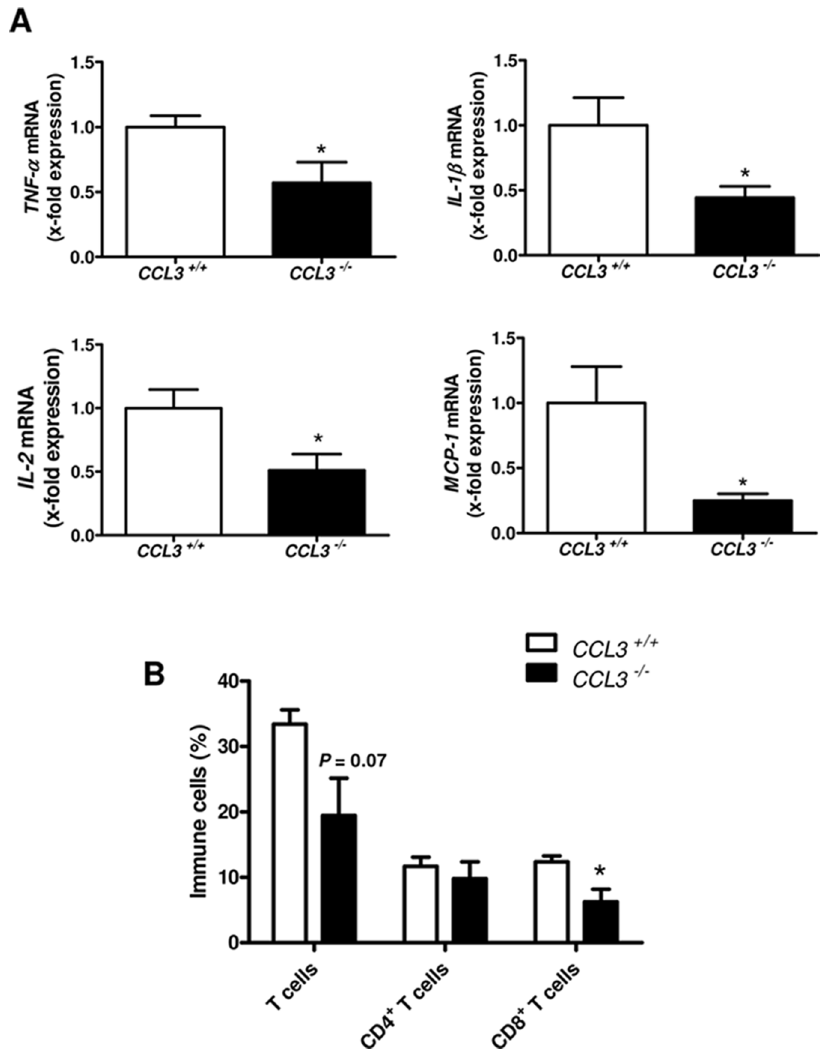
Figure 5. Inflammation is reduced in CCL3 2 / 2 mice treated with CCl 4 . CCL3 2 / 2 mice treated with CCl 4 show altered expression of the inflammation-related genes TNF- a , IL-1 b , IL-2 and MCP-1 compared to wild-type mice ( A ). CD8 + T cell infiltration is significantly decreased in CCL3 2 / 2 mice ( B ). Data are expressed as means 6 SEM of eight mice per group. * P , 0.05.